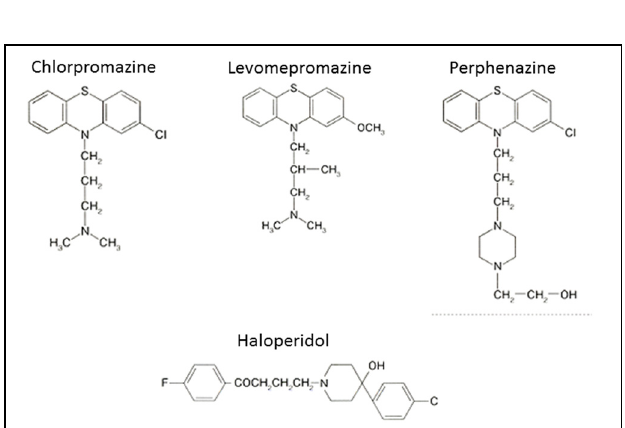
FIGURE 1 | Historical overview of the development of antipsychotic drugs.